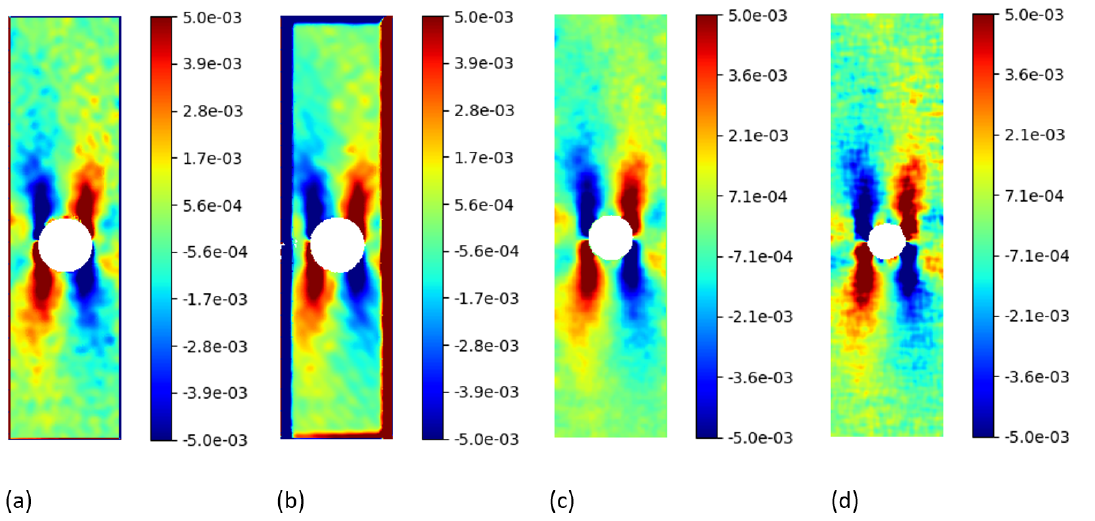
Figure 8. E xy Green Lagrangian strains for the “plate hole” sample from SEM DIC challenge obtained from DIC technique. ( a ) py2DIC results using Gaussian filter ( b ) py2DIC results using spline filter ( c ) Ncorr results ( d ) DICe results.